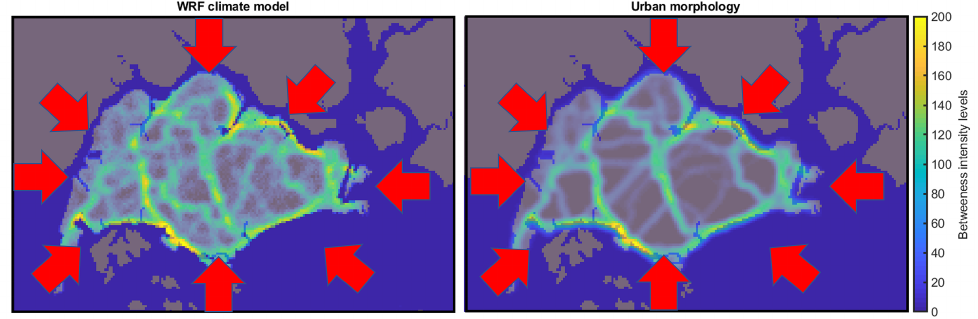
Figure 7. Comparison of the network model ( right panel) with the climate model ( left panel). The results are based on the accumulation of all eight directions, θ A = { 0, π /8, . . . ,7 π /8 }